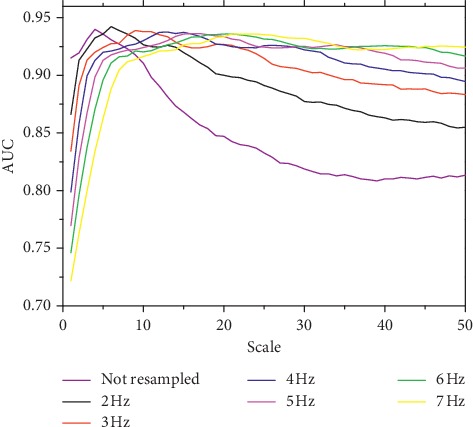
AUC of DC obtained from clinical data at different scales with and without preprocessing.